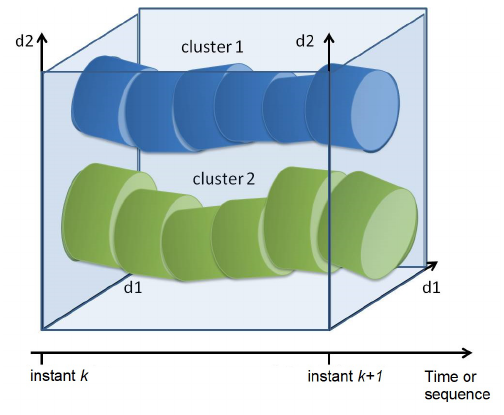
Figure 2. Example of type 2 dynamic segmentation.